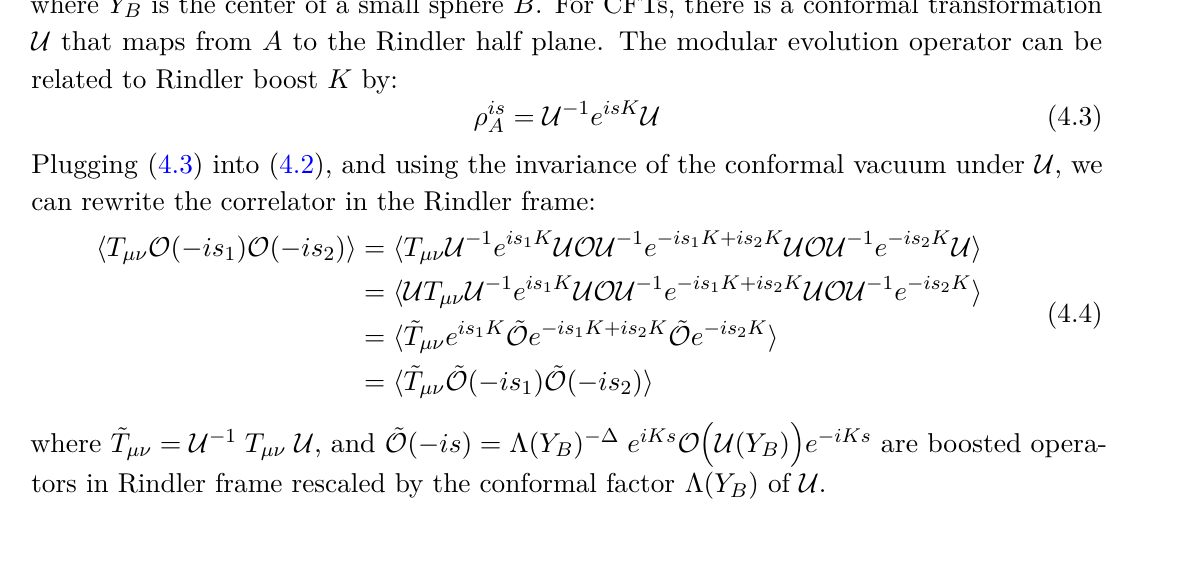
= L, Y = 0 . The angular coordinate α on ∂A is 1 i 1